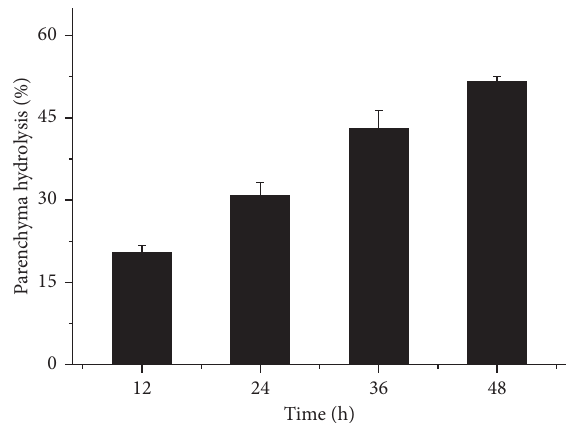
Figure 5: Percentage of hydrolysis of the parenchymal cells by the crude enzymatic extract at different times. The error bars represent the mean ± SD ( n �